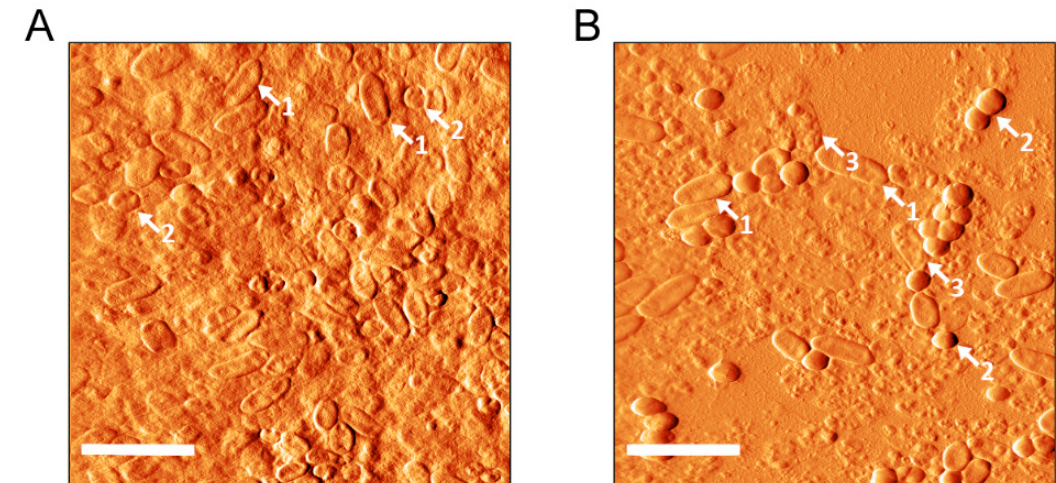
Figure 4. AFM images of the dual-species biofilm of PA002 + Sa3. Biofilms were grown for 24 h and then treated for further 24 h with no peptide Hs02 ( A ) or with 128 µ g / mL of the peptide ( B ). Scale bars correspond to 5 µ m. Some features discussed in the text are indicated as follows: 1: undamaged PA002 cells; 2: undamaged Sa3 cells; 3: damaged PA002 cells.